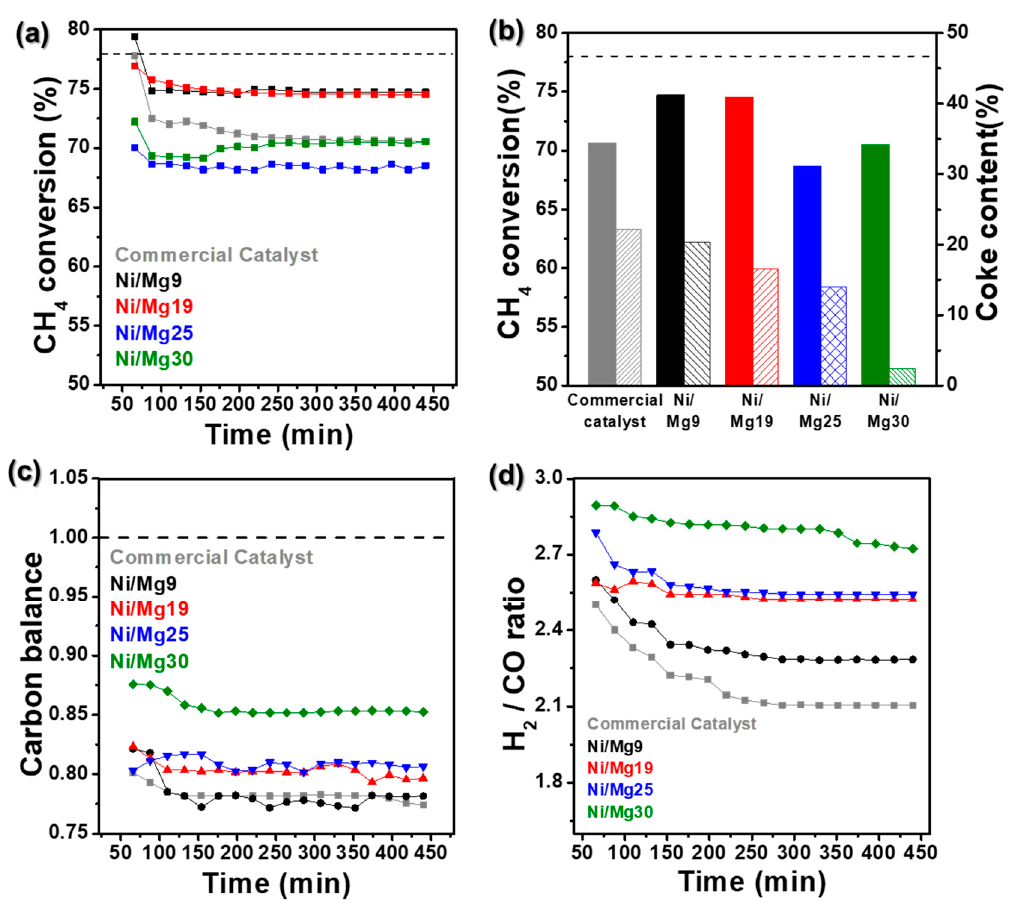
Figure 7. Time-on-stream result of SMR reaction under accelerated deactivation conditions at 700 °C and GHSV of 8000 h − 1 with S / C of 1: ( a ) CH 4 conversion, ( b ) averaged CH 4 conversion and coke contents measured by TGA analysis, ( c ) carbon balance, and ( d ) H 2 /CO ratio.